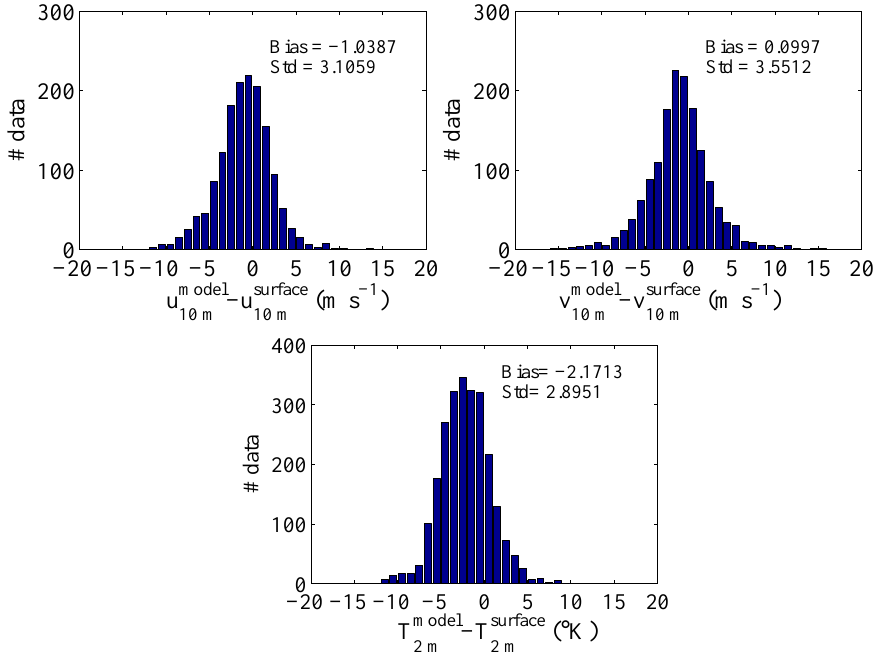
Fig. 4. Histograms of the difference between the three-hourly simulated and measured 10-m zonal (a) and meridional (b) wind components and 2-m temperature (c) during the 24h period of 24 March 1998 in southern France (see dots in Fig. 1b). The measured 10-m wind speed and 2-m temperature accuracies are 1ms − 1 and about 0.1 ◦ K, respectively.